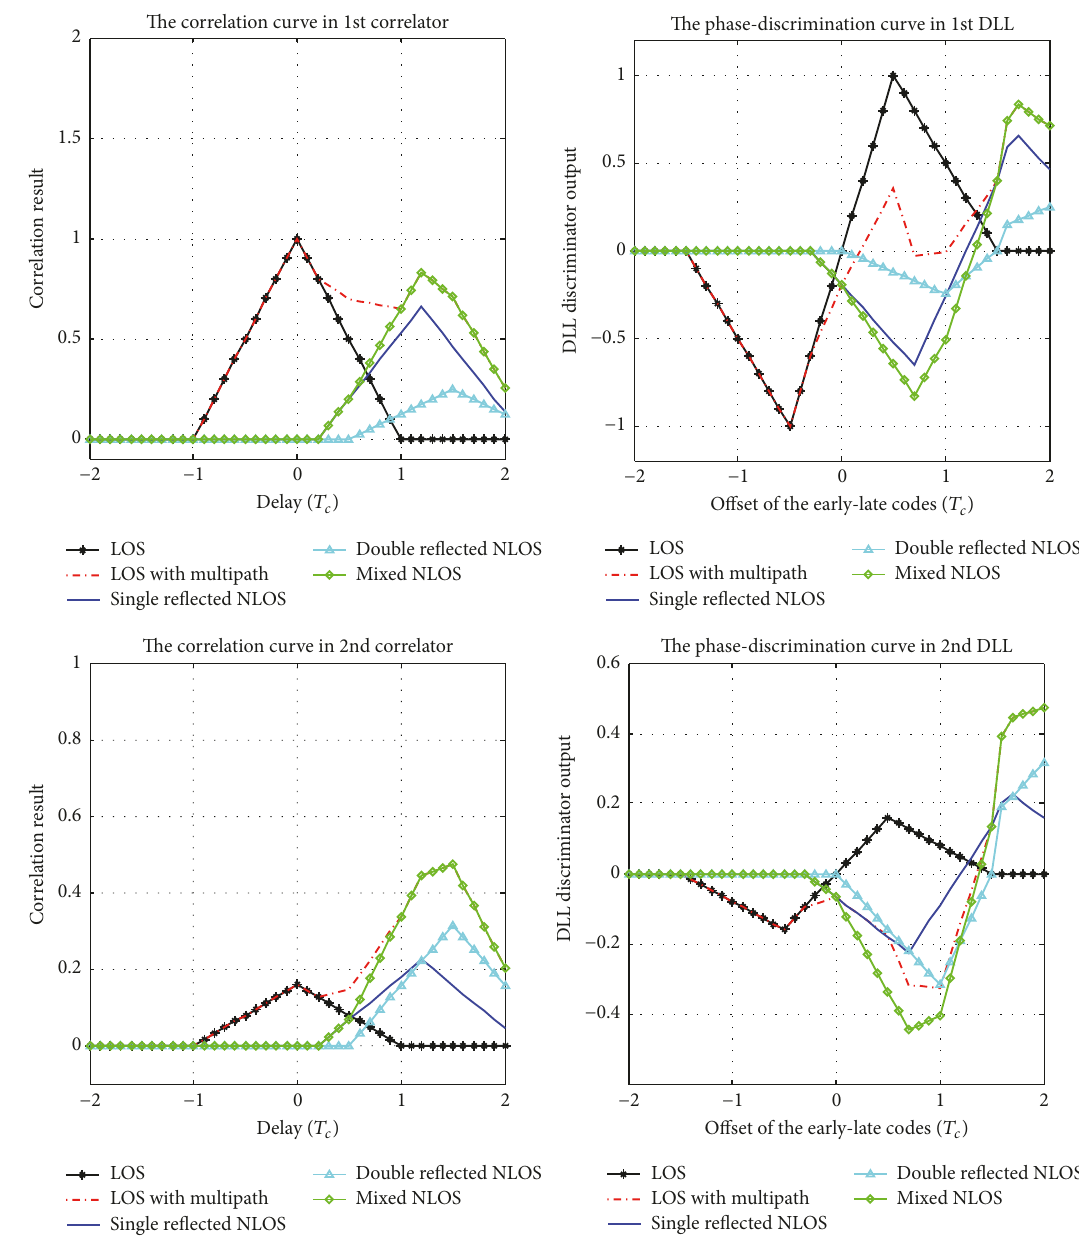
Figure 7: Correlation results for parallel cross-cancellation receiver at elevation 10 ∘